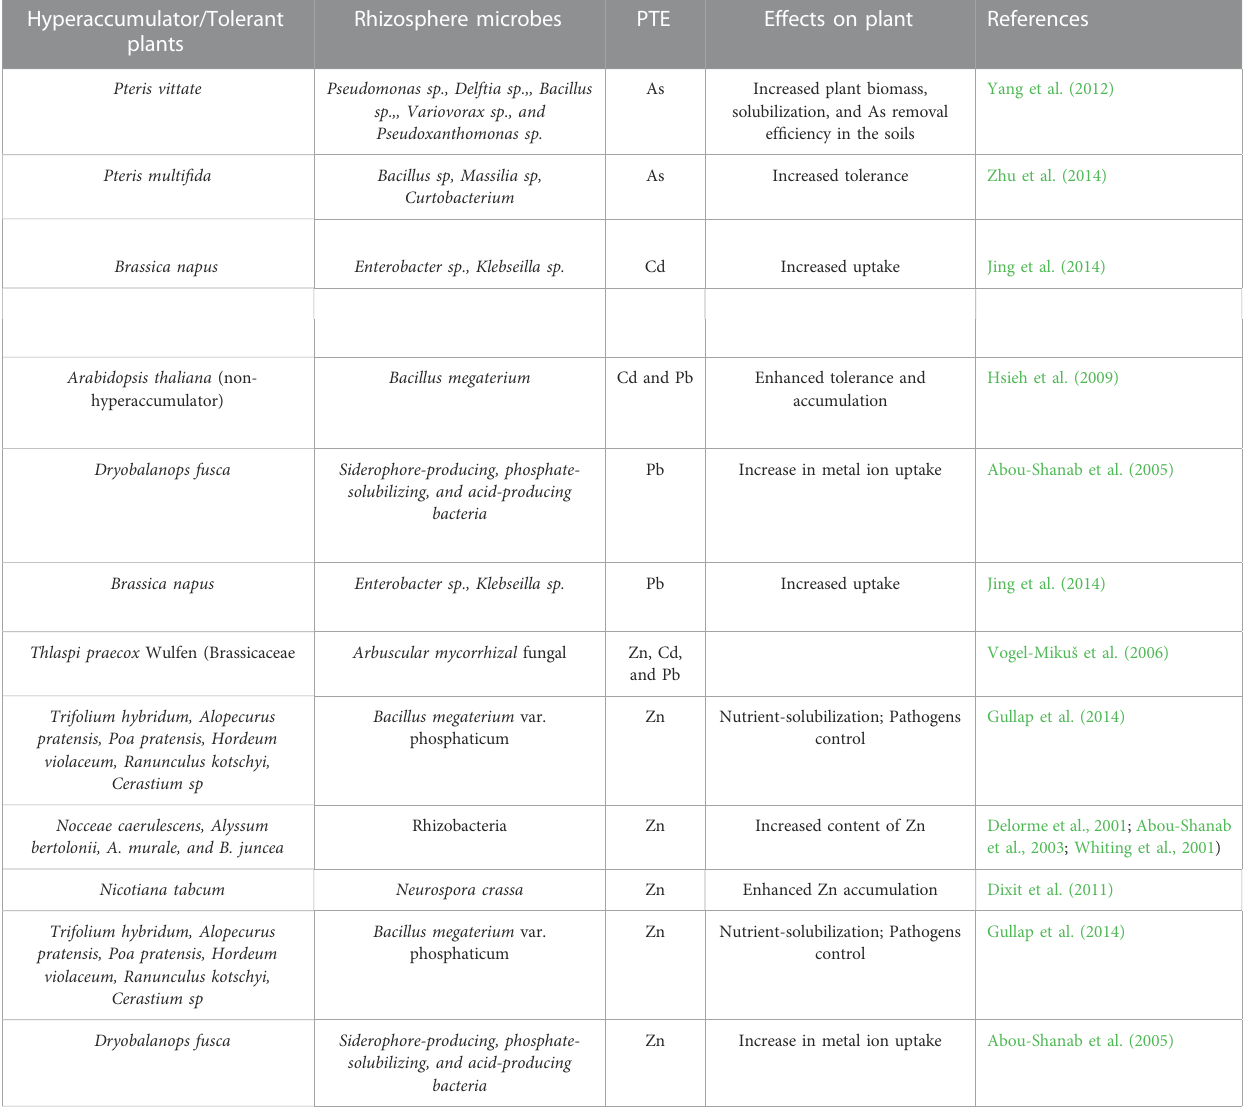
TABLE 3 Effects of rhizosphere microbes on plant hyperaccumulators/tolerant of Potentially toxic elements